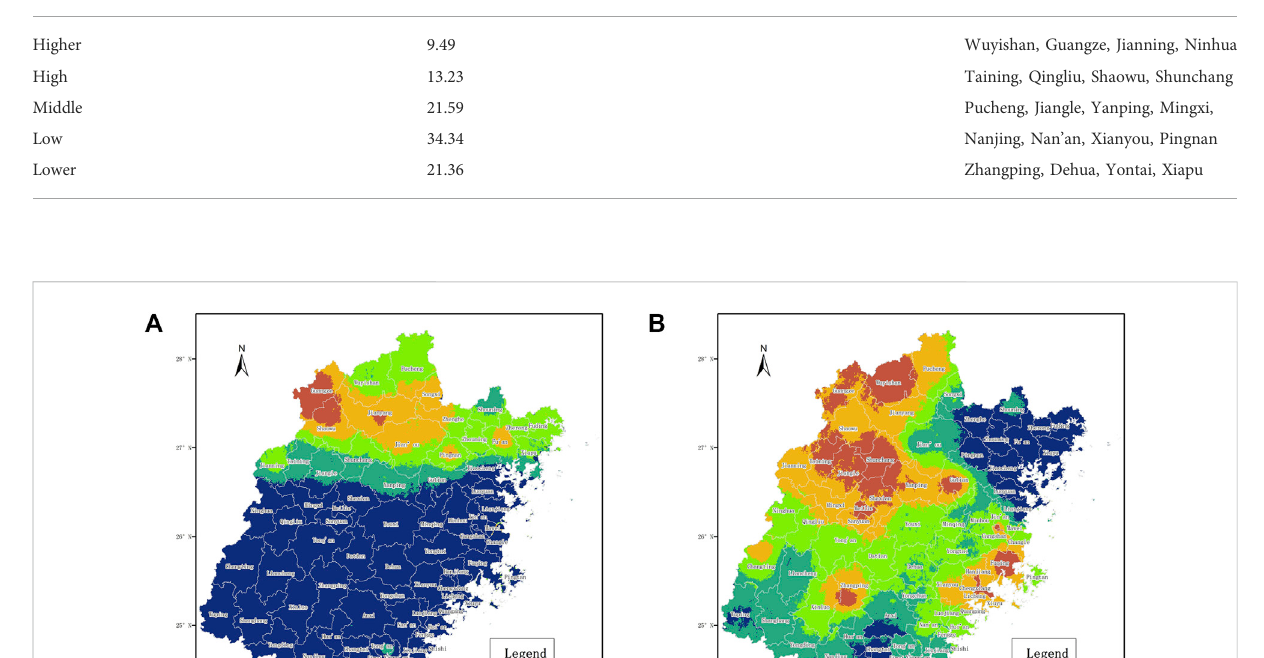
Frontiers in Environmental